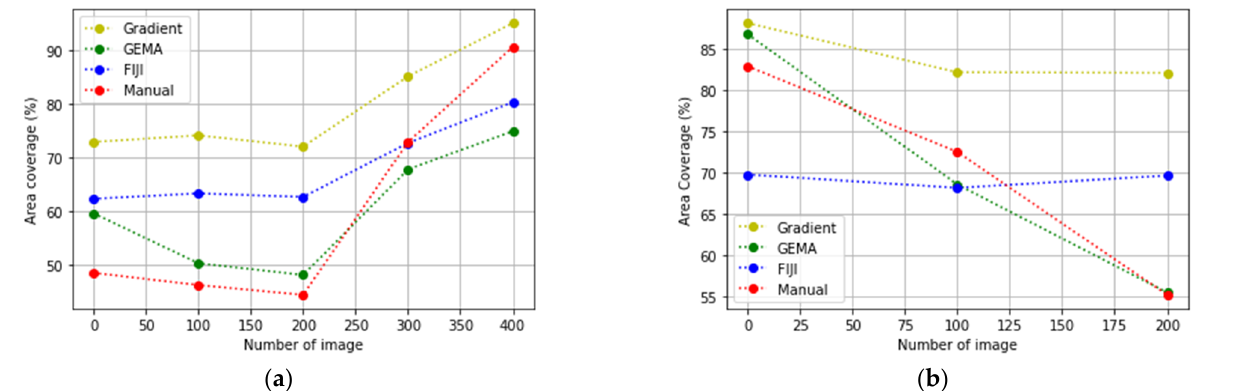
Figure 10. Results from Dataset_1 ( a ) The evolution to confluency stage; ( b ) the evolution to apoptosis stage.